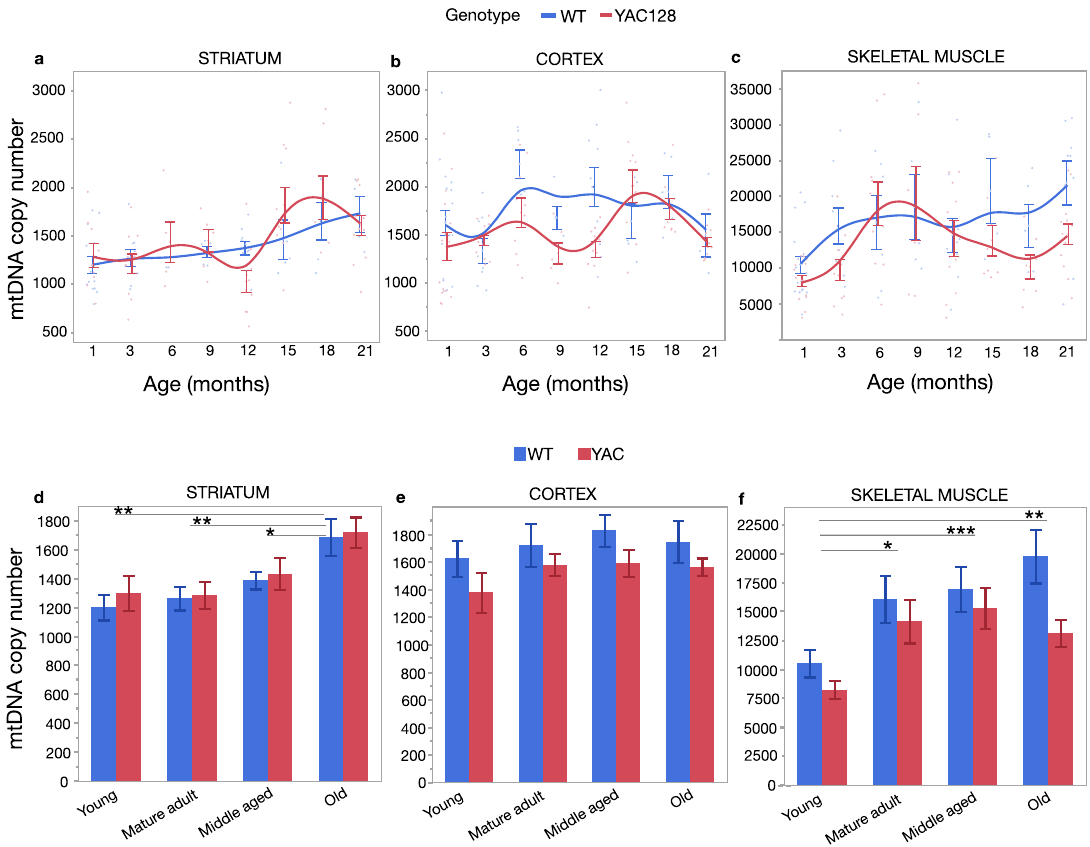
Fig. 2 Quanti fi cation of mtDNA copy number (mtDNAcn) in striatum, cortex and skeletal muscle. For each DNA sample, the single-copy nuclear gene for the polymerase gamma 2 accessory subunit ( Polg2 ) and the mitochondrial gene for cytochrome c oxidase 1 subunit gene ( mt-Co1 ) were quanti fi ed by qPCR and presented as mtDNA:nDNA ratio. a In the striatum, the mtDNAcn increased in an age-dependent manner with no difference between the YAC128 and WT mice. b In the cortex, the mtDNAcn increased between 1 and 9 months of age followed by a decrease between 9 and 21 months of age, with signi fi cantly lower mtDNAcn in the YAC128 mice. c The mtDNAcn in skeletal muscle increased signi fi cantly between 1 and 9 months of age, followed by a decrease between 9 and 21 months of age, with signi fi cantly lower mtDNAcn in the YAC128 mice. Lines represent the fi tted means of WT (blue) and YAC128 (red) with s.e.m. The sample size ranges from 4 to 18 per group at each time point (for striatum; WT 6 months, n = 1) (see also Supplementary Tables 1 – 3). d In the striatum, age had a signi fi cant effect on mtDNAcn with no effect of genotype. The mtDNAcn was signi fi cantly increased in old mice (18 – 21 months) compared to young (1 month), mature adult (3 – 6 months) and middle-aged mice (9 – 15 months). e In the cortex, genotype had a signi fi cant effect with no effect of age with the YAC128 mice displaying signi fi cantly lower mtDNAcn compared to the WT mice. f In the skeletal muscle, both age and genotype had a signi fi cant effect on mtDNAcn. There was a progressive increase in mtDNAcn in mature adult, middle-aged and old mice compared to young mice, while the mtDNAcn was signi fi cantly lower in the YAC128. Multivariate regression analysis, fi tting age as a categorical variable, with Tukey ’ s multiple comparison test was used for analysis. Bars represent means with s.e.m. WT (blue) and YAC128 (red).